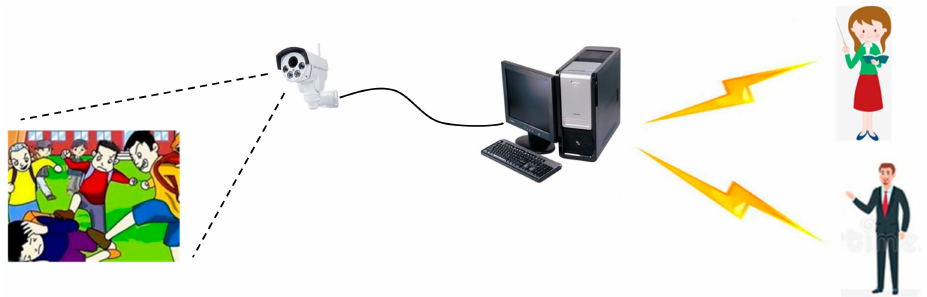
Figure 1. Structure of the violence detecting